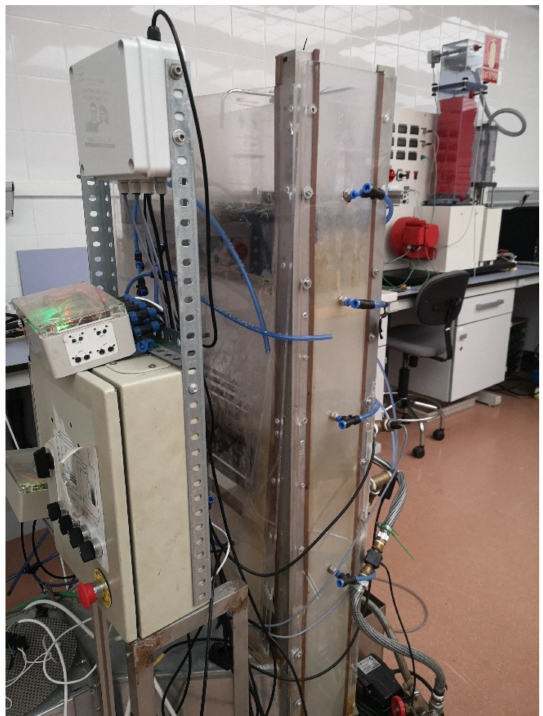
Figure 2. Experimental